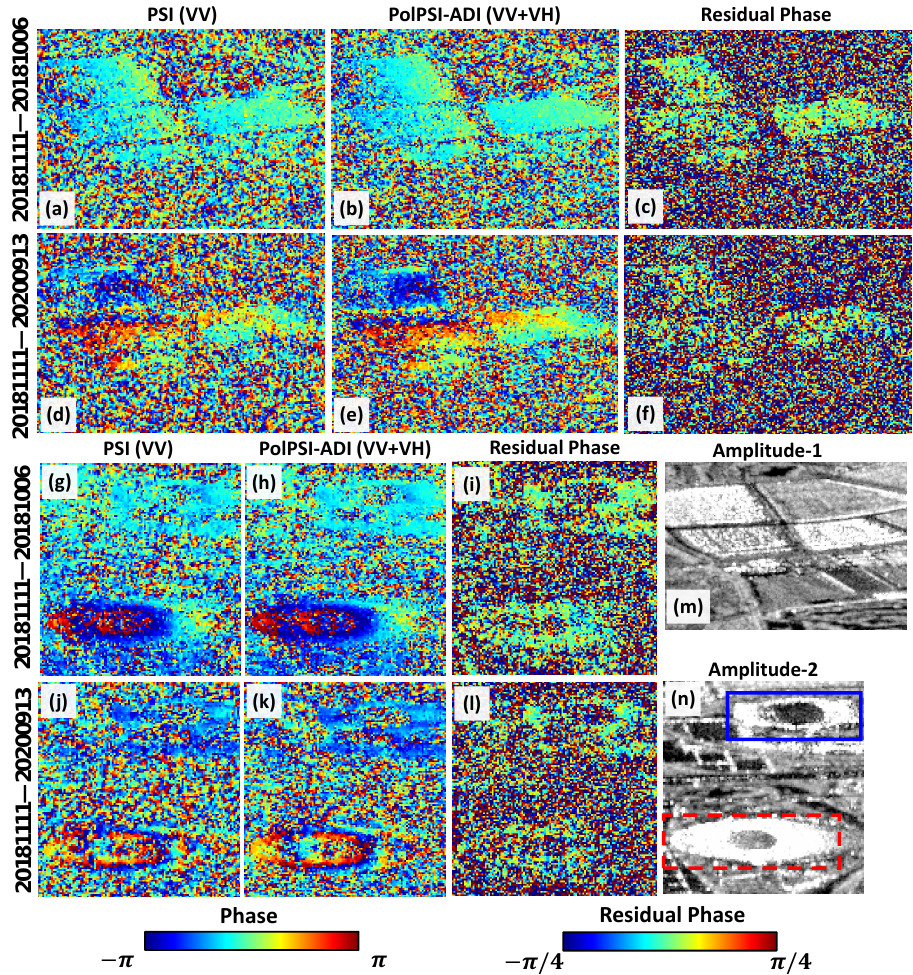
Figure 5. Interferograms of VV channel ( a , d , g , j ) and the corresponding optimized ones via PolPSI- ADI approach ( b , e , h , k ) of two subsections over Beijing test site. ( c , f , i , l ) are the corresponding residual phase maps (i.e., PolPSI-ADI phase minus PSI phase). ( a – f ) are over the first sub-area, while ( g – l ) are over the other one, and ( m , n ) are the corresponding average amplitude images of these two subsections. The number on the left of each row indicates the interferograms and residual phase maps related temporal baselines, all the subfigures are in SAR